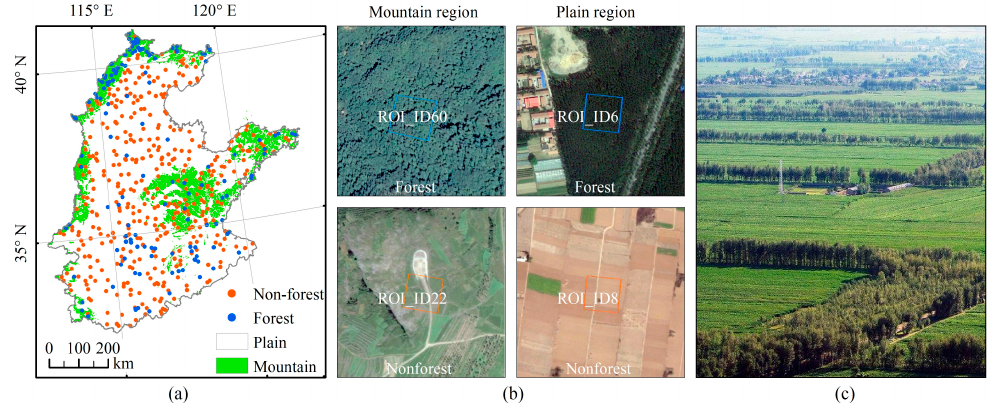
Figure 4. Extraction of validation regions of interest (ROIs) for the resultant PL-based map. ( a ) Spatial distribution of validation ROIs; ( b ) four ROIs including the mountain region and plain region from the very high resolution (VHR) images of Google Earth from around 2010; ( c ) a typical agroforest landscape surrounding a crop field (the photo was taken in 2015).